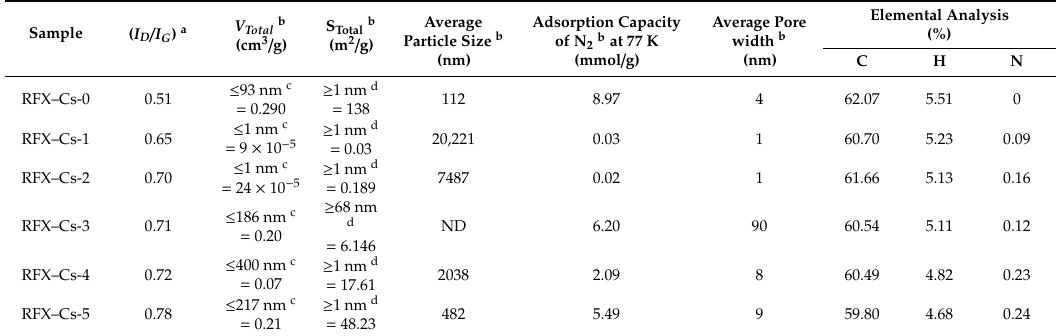
Summary of parameters derived from Raman spectra, surface area analyzer, and CHNS / O